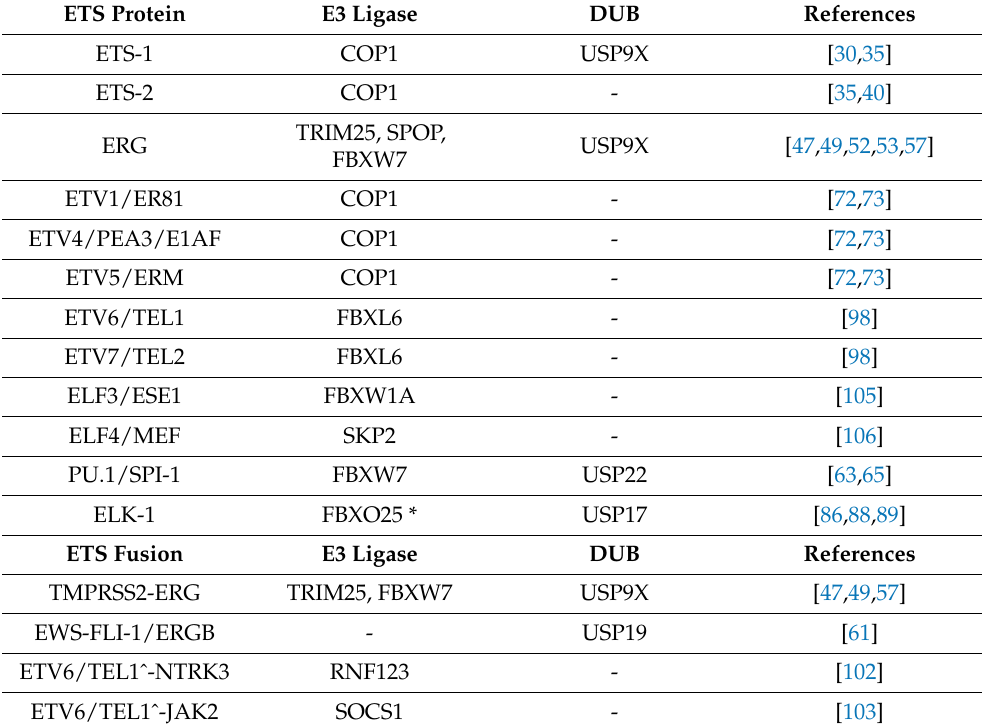
Table 1. E3 ligases and DUBs reported to facilitate ubiquitination and deubiquitination of human ETS proteins and their oncogenic fusions (* Disputed, ˆLacks ETS